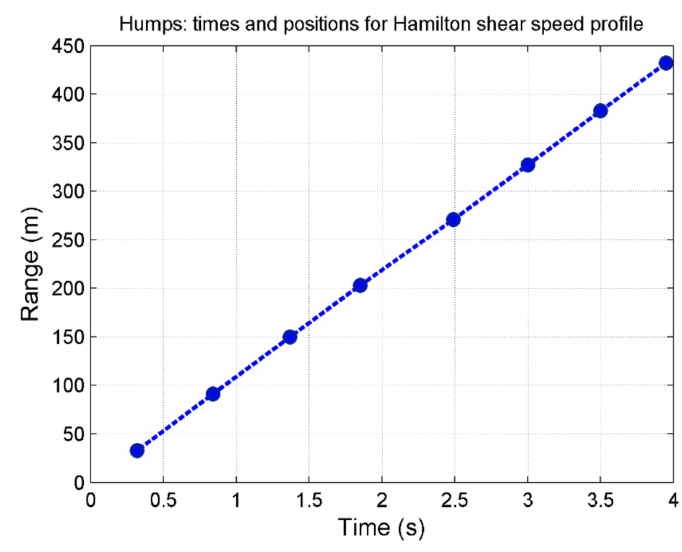
Figure 9. Times and positions of successive humps for the Hamilton profile model pwb42.